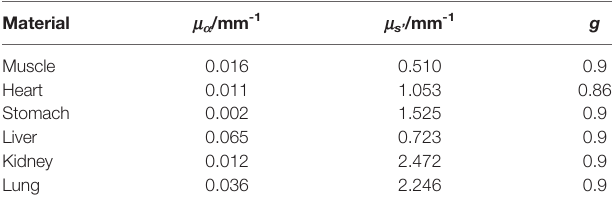
TABLE 1 | Optical parameters of different tissues and organs of the numerical mouse.